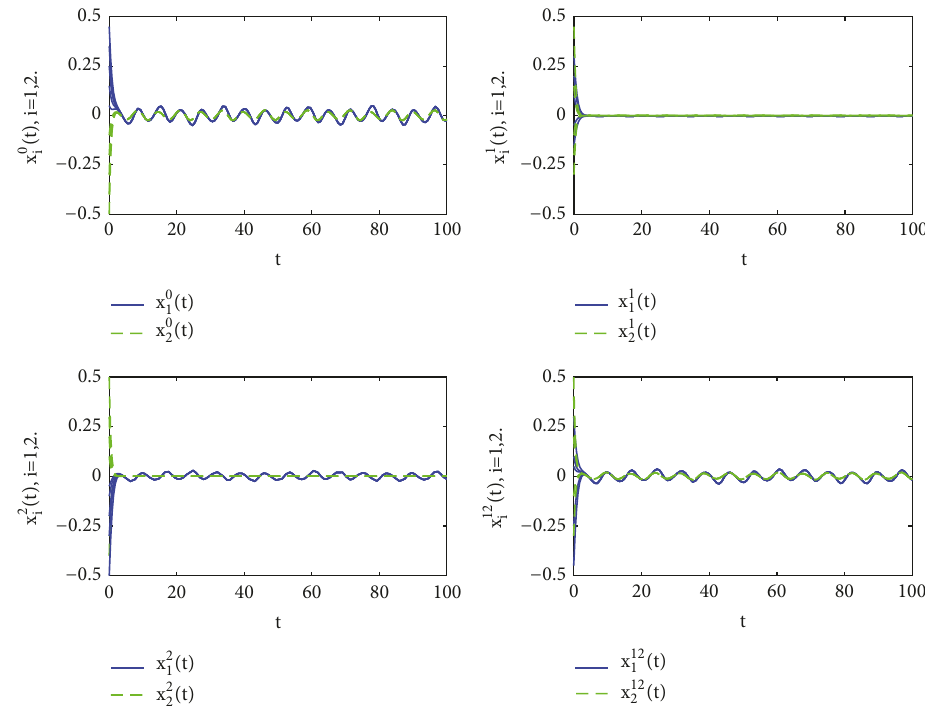
Figure 1: The states of 𝑥 0 (𝑡) , 𝑥 1 (𝑡) , 𝑥 2 (𝑡) , and 𝑥 12 (𝑡) in (42) without any controller.